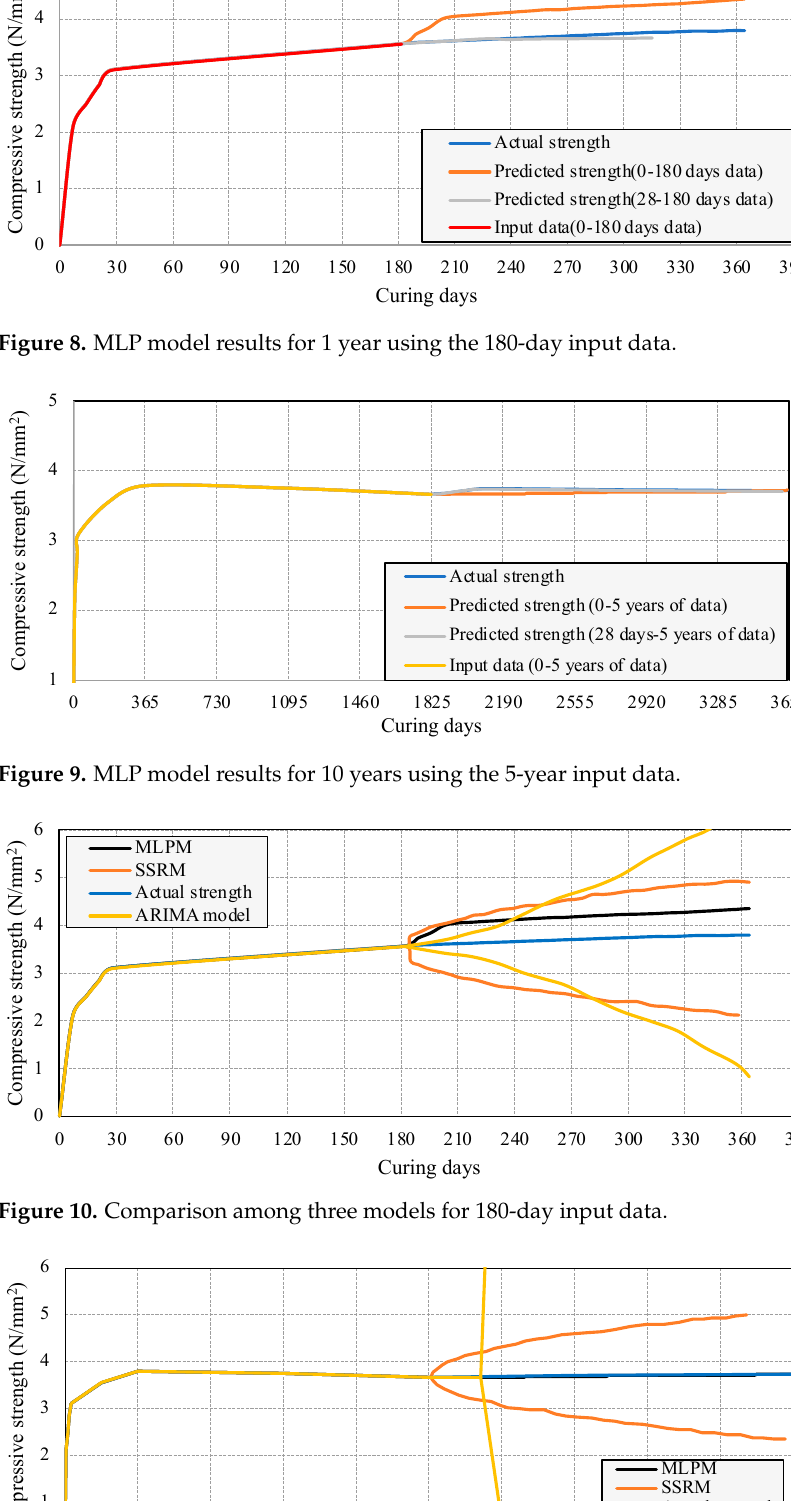
Figure 8. MLP model results for 1 year using the 180 ‐ day input data.